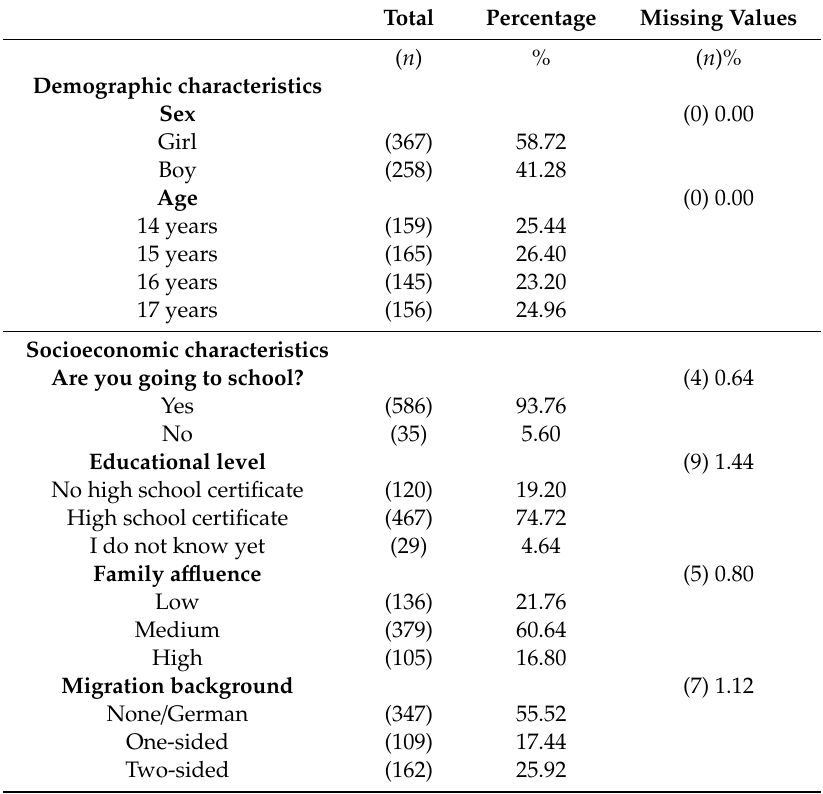
Table 2. Sample characteristics in stage 2 of the MOHLAA study ( n =